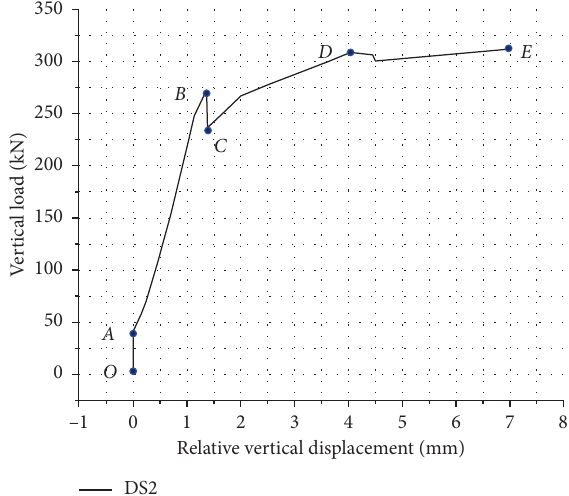
Figure 7: DS2 vertical load vs. relative vertical